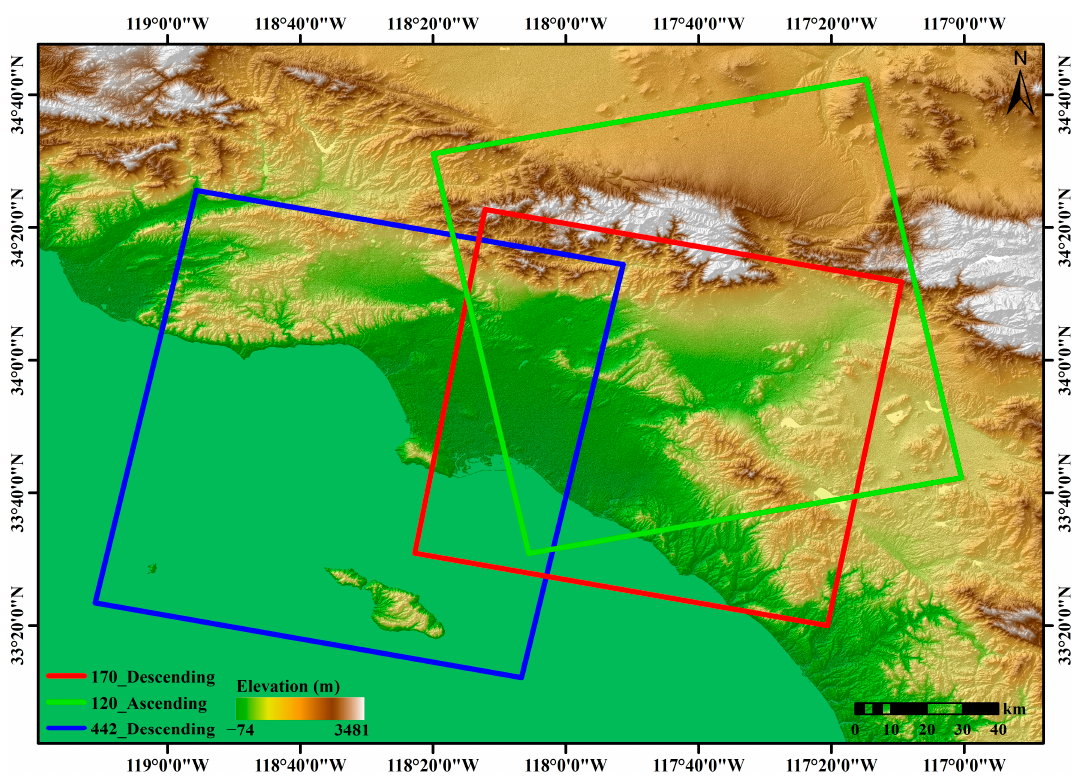
Figure 2. Coverage of three SAR datasets. Blue rectangle is track 442, red rectangle is track 170, and green rectangle is track 120. The background is SRTM DEM with a resolution of 30 m.